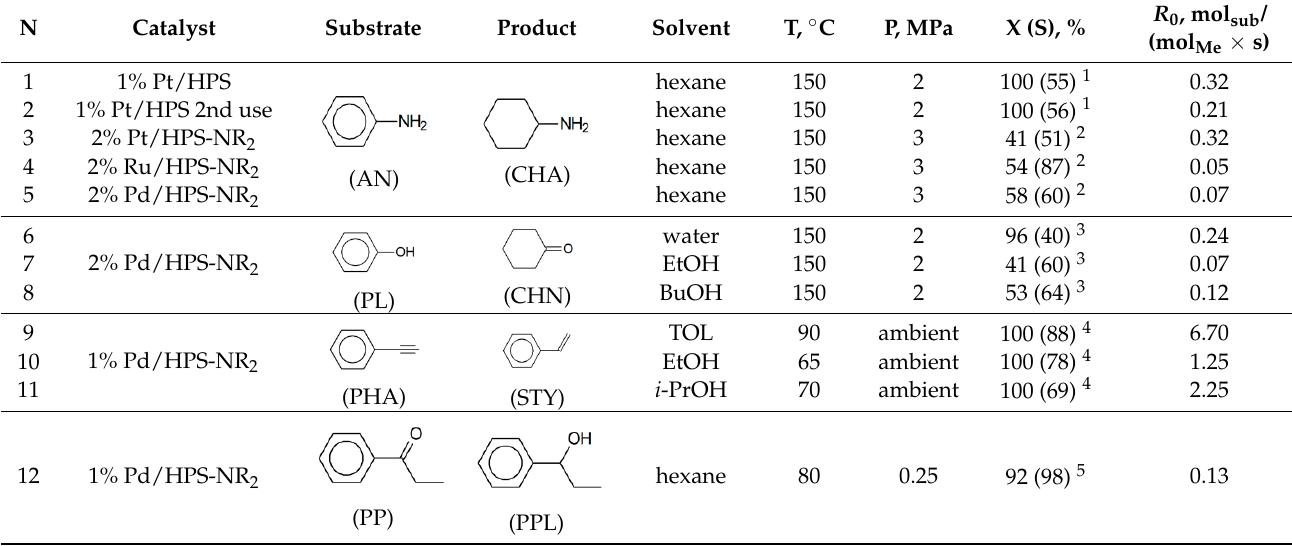
Figure 7. CHA accumulation using different noble metal NPs supported on HPS-NR 2 (150 ◦ C, 3 MPa, Table 2. Data of catalytic testing of HPS-based catalysts in hydrogenation of substituted aromatics. C AN ,0 = 0.41 mol/L, catalyst loading 100 mg). Table 2. Data of catalytic testing of HPS-based catalysts in hydrogenation of substituted aromatics. Table 2. Data of catalytic testing of HPS-based catalysts in hydrogenation of substituted aromatics. Table 2. Data of catalytic testing of HPS-based catalysts in hydrogenation of substituted aromatics. Table 2. Data of catalytic testing of HPS-based catalysts in hydrogenation of substituted aromatics. Table 2. Data of catalytic testing of HPS-based catalysts in hydrogenation of substituted aromatics. Table 2. Data of catalytic testing of HPS-based catalysts in hydrogenation of substituted aromatics.